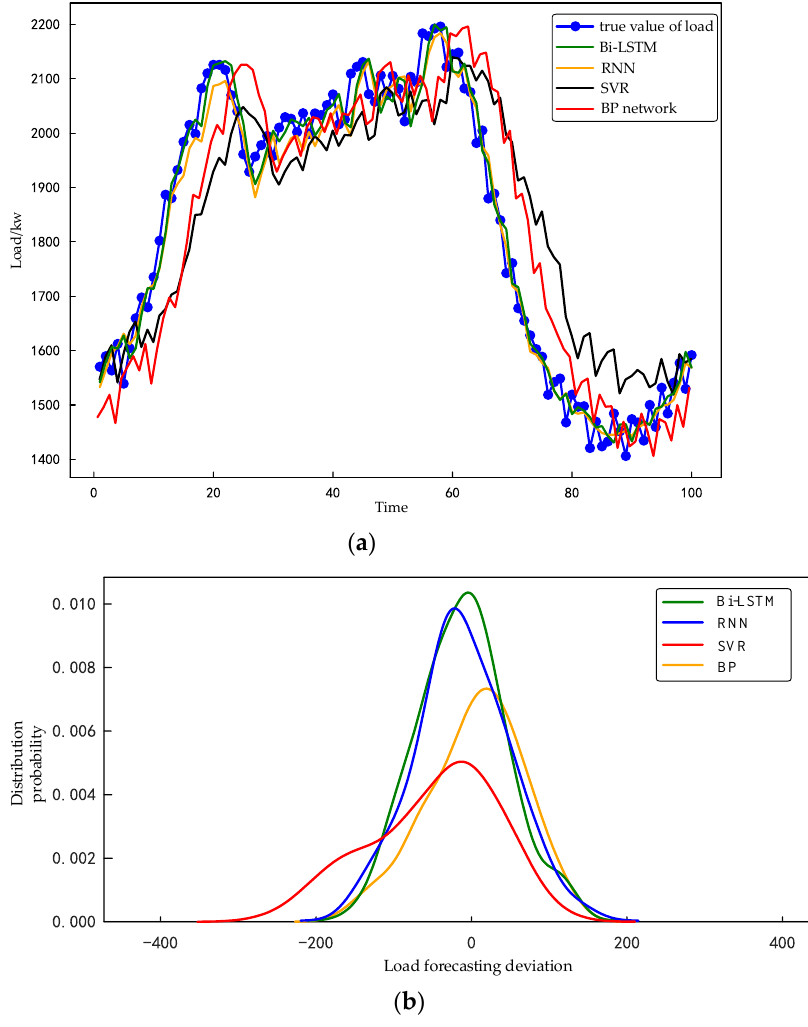
Figure 12. Comparison of prediction results of source domain: ( a ) Comparison of prediction results of different models; ( b ) Prediction error distribution curve of different models.